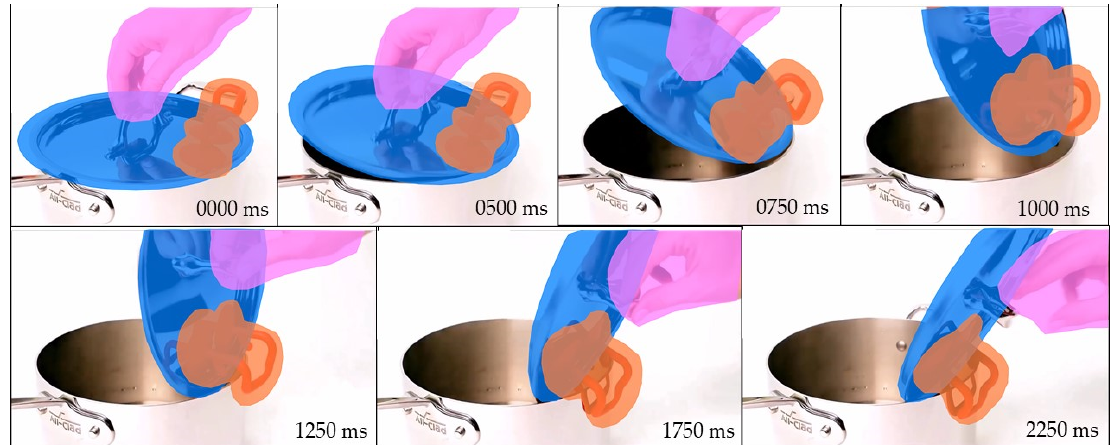
Figure 3. Areas of Interest studied for each product.